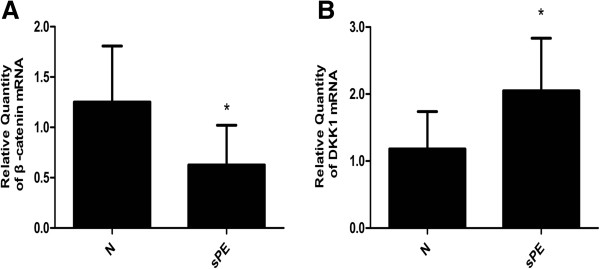
Relative quantity of β-catenin and DKK1 mRNA expression in normal and severe preeclampsia group. Representative data are shown: (A) the relative quantity of β-catenin mRNA expression. (B) The relative quantity of DKK1 mRNA expression. Results indicated that β-catenin and DKK1 mRNA expression could be detected in both the normal control (N) and severe preeclampsia (sPE) groups. Compared with the control group, the β-catenin mRNA expression was significantly decreased and the DKK1 mRNA expression was significantly increased in sPE group (p<0.05). (Data are presented mean ± SD, n=30 for each group, *p < 0.05, respectively).